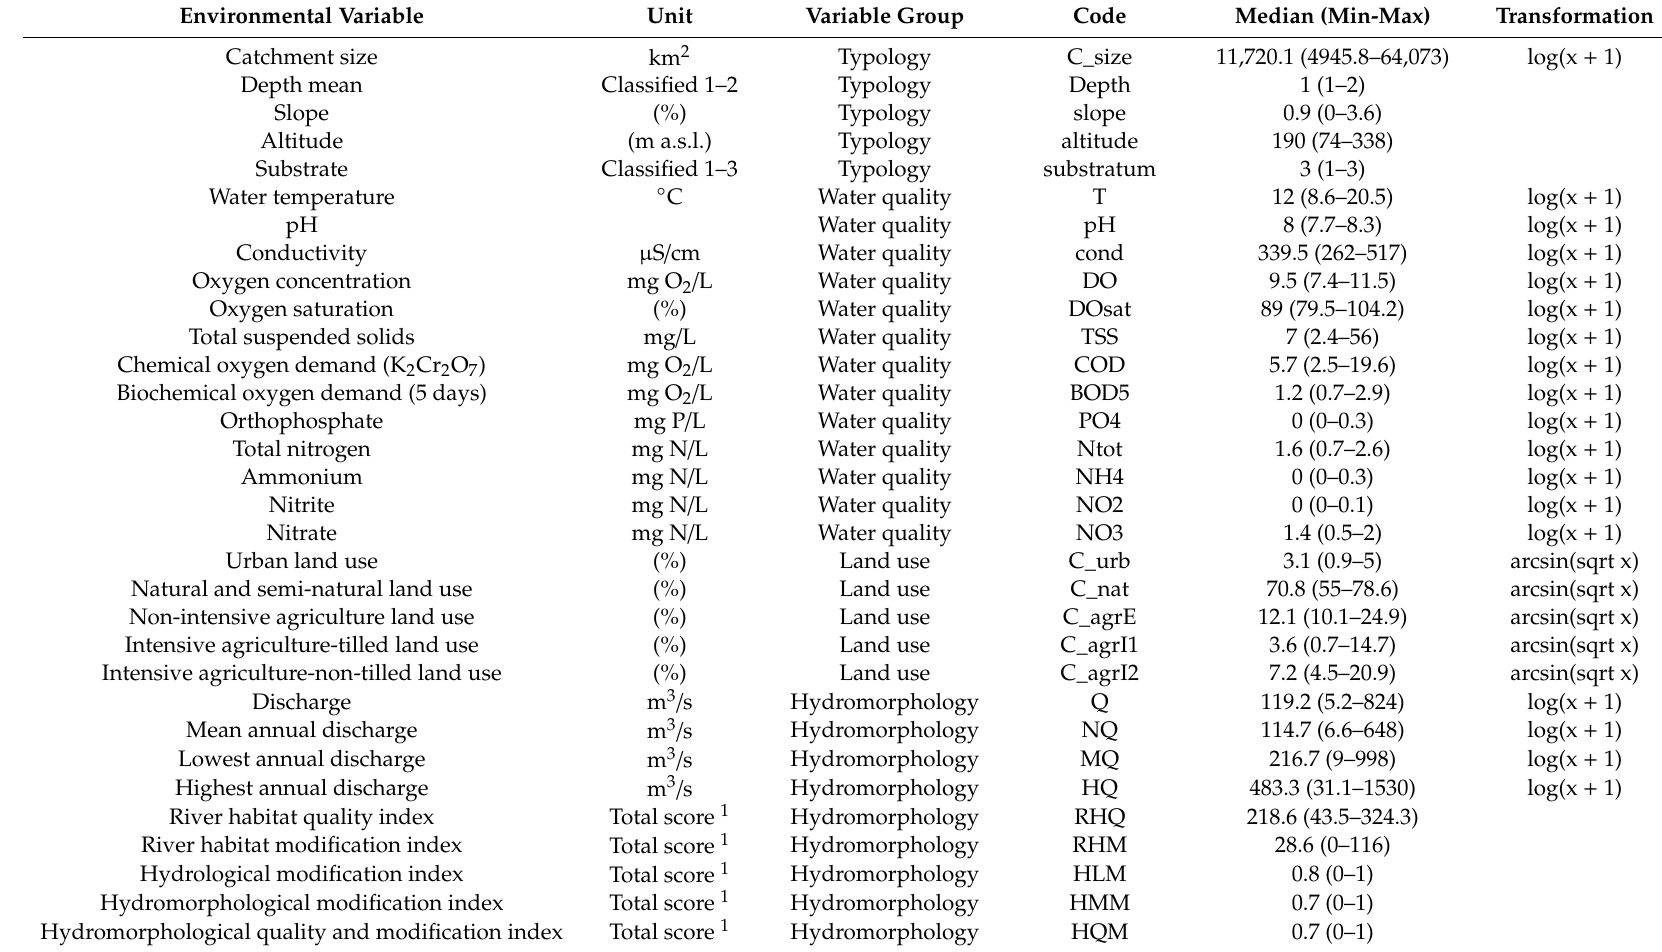
Table 2. Groups of environmental variables with their Median, Min (minimum) and Max (maximum)